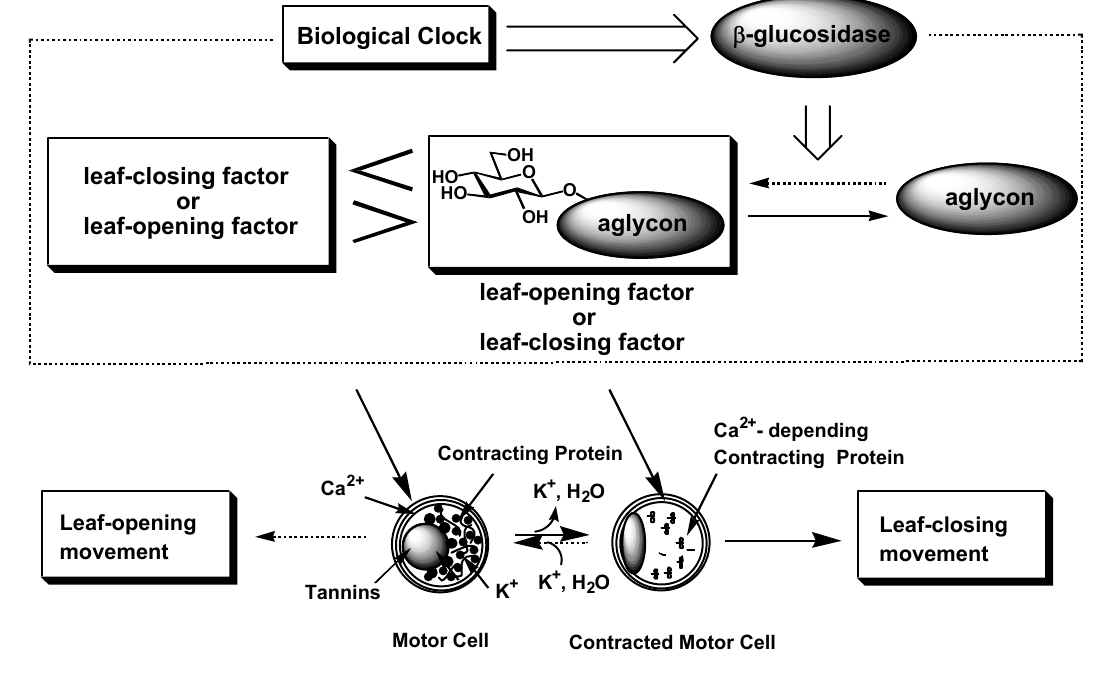
Figure 5. Universal mechanism of nyctinasty controlled by a biological